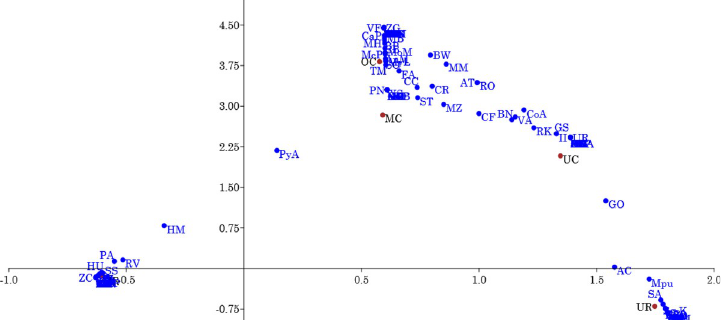
Fig 3. Correspondence analysis biplot showing species distribution among different vegetation strata in reclaimed and natural forest stands. OC, MC, and UC = overstorey, midstorey, and understorey species respectively on control sites, and OR, MR, and UR = overstorey, midstorey, and understorey species respectively on reclaimed sites. Axes 1 and 2 explained 33.5 and 29.7% of the total variation, respectively. List of species: AM—Acacia mangium ,